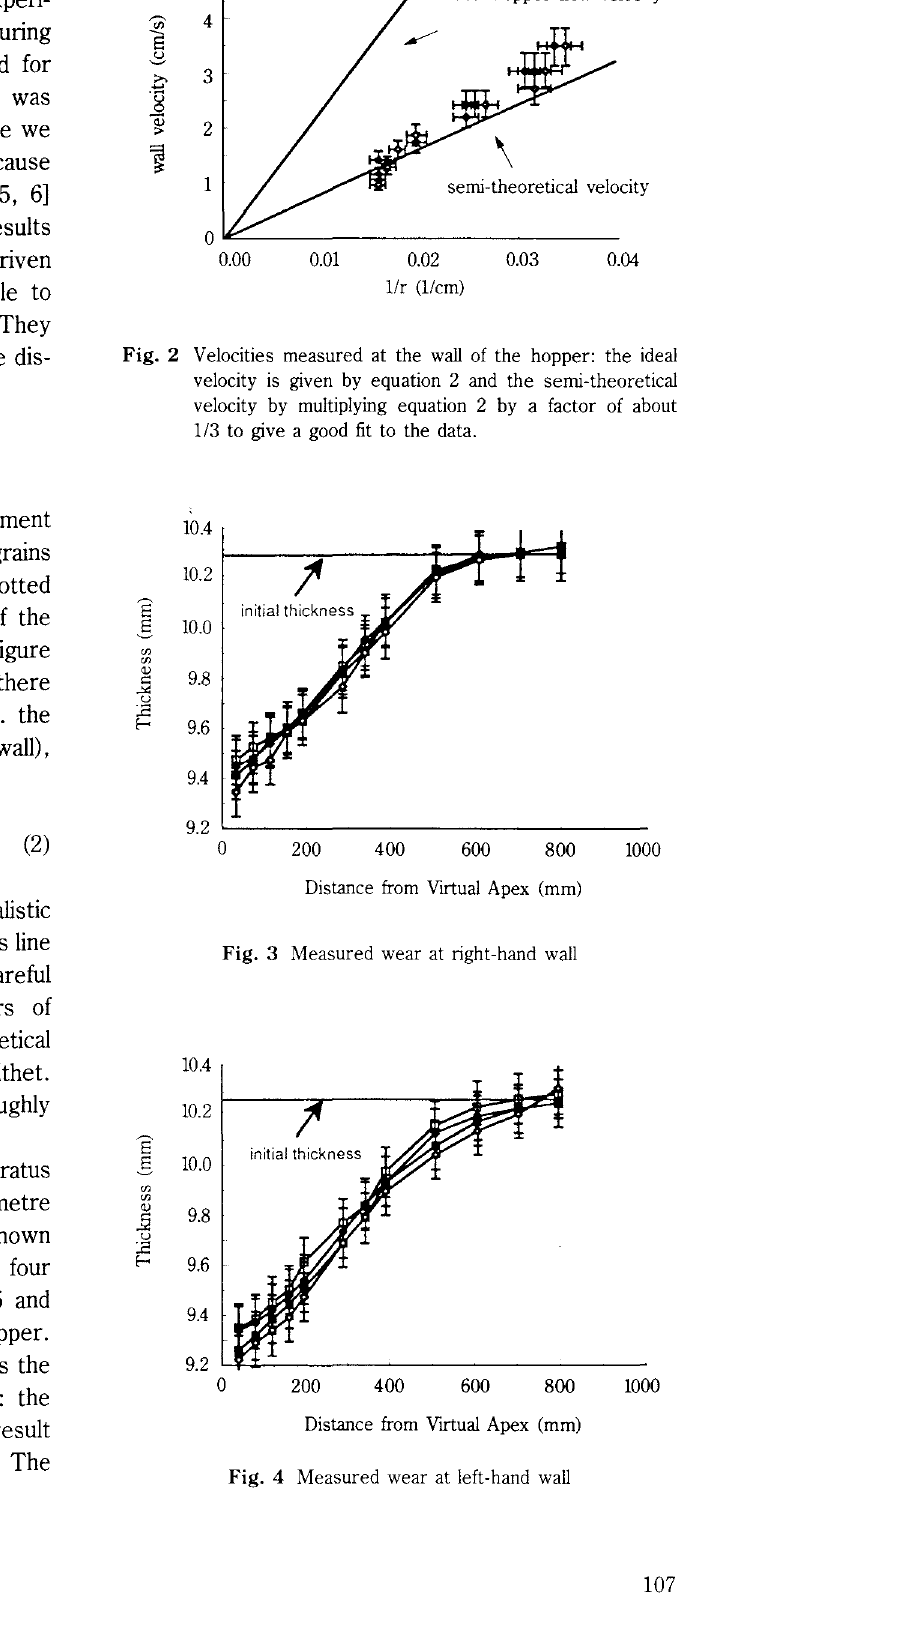
Fig. 4 Measured wear at left-hand